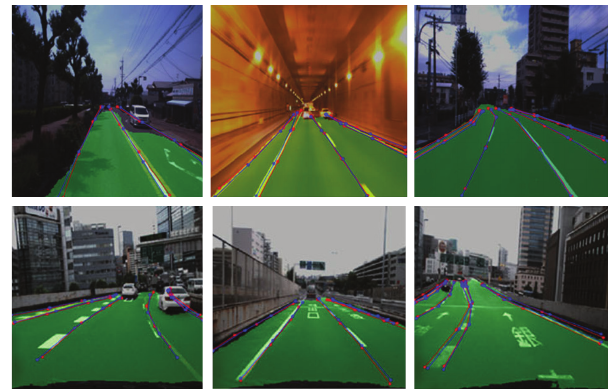
Figure 17. The results of lane prediction based on the method presented in